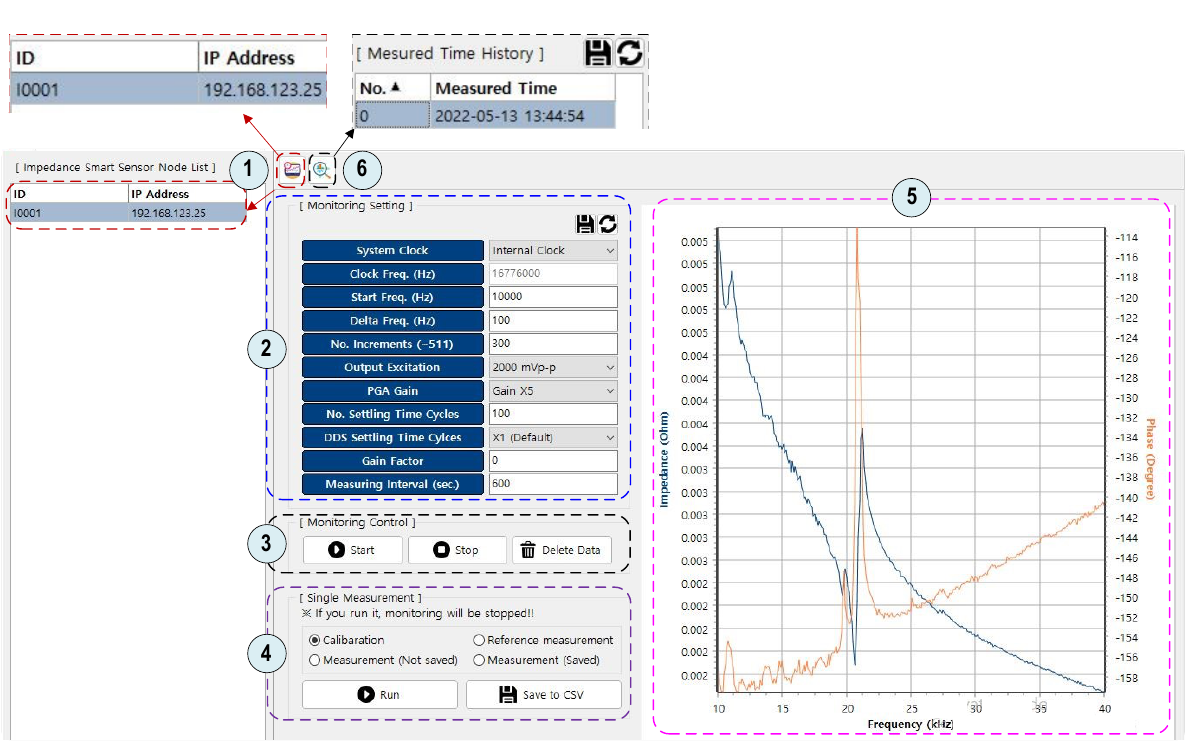
Figure 9. GUI software for Raspberry Pi system —’ SSeL ’ impedance sensor node.